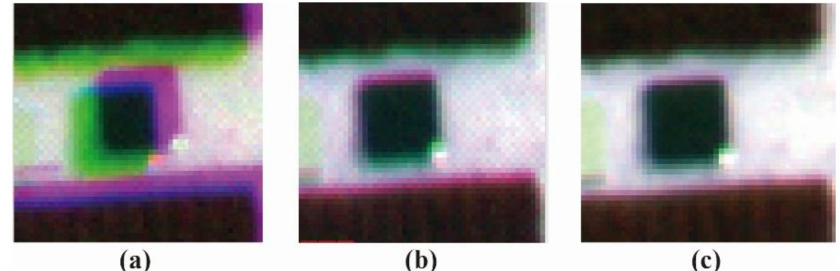
Figure 9. Mini-MCA6 multispectral images from different band registration methods. ( a ) Original